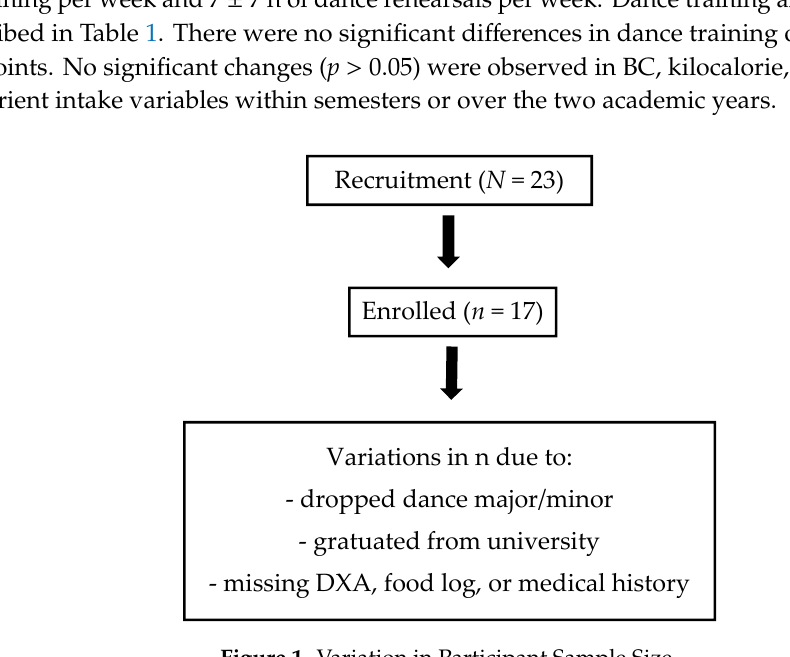
Figure 1. Variation in Participant Sample Size.